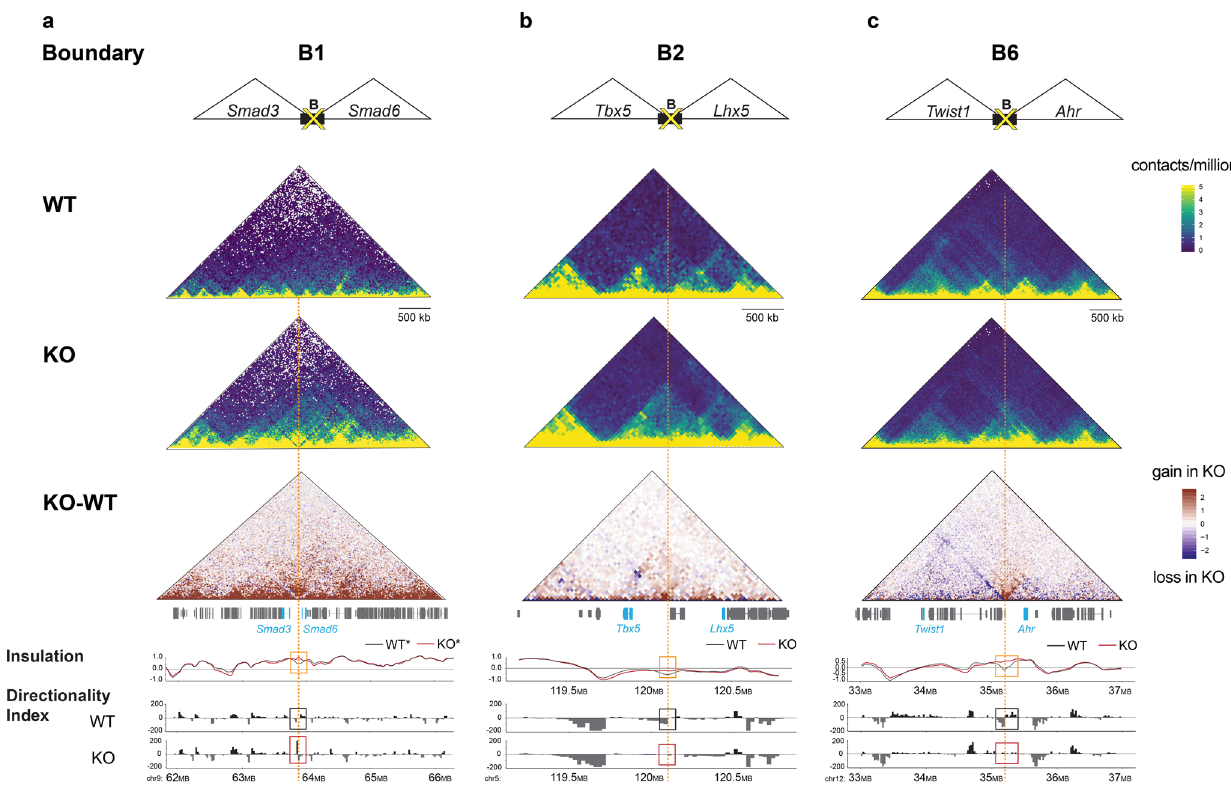
Fig. 3 Boundary deletions result in abnormal TAD architecture. Hi-C derived interaction maps for TAD boundary loci B1 ( a ), B2 ( b ), and B6 ( c ). Cartoon of the TAD boundary deleted, with select developmental genes within the TADs fl anking the deleted boundary (B), followed by three heatmaps showing Hi-C contact data. Heat maps (yellow-blue color-code) show Hi-C contact matrices presented as observed/expected contacts at 25 kb resolution in representative wild-type (WT) and knockout (KO) mouse liver tissue samples. For TAD boundary locus B1, note that the WT represents the wild-type allele in Cast background and KO represents the deletion allele in FVB background from an animal heterozygous for the TAD boundary deletion. The third heatmap (red-blue color-code) shows net changes in Hi-C interaction frequencies in the KO relative to WT. Positions of genes within the corresponding locus are indicated along the heatmap. The dashed orange vertical line indicates the position of the deleted boundary. Insulation pro fi les for the WT and KO samples corresponding to the heat maps are shown. The insulation pro fi le assigns an insulation score to each genomic interval 50 , with local minima representing the most insulated region. Note the deviation from the minima in the insulation pro fi le for the KO compared to WT (orange box), indicating loss of insulation in the KO. Bar plots show the Directionality Index (DI) 5 for the same samples. Boundaries are called at regions where abrupt and signi fi cant shifts in upstream and downstream contacts are observed, as depicted in the WT (black box). Note either gain in contacts or the loss of demarcation between upstream and downstream contacts at the deleted site in the KO (red box). Genome coordinates shown are in mm10. More details on mouse strain background where applicable, replicates and additional TAD boundary deletions are provided in Supplementary Fig. 4 and “ Methods ”